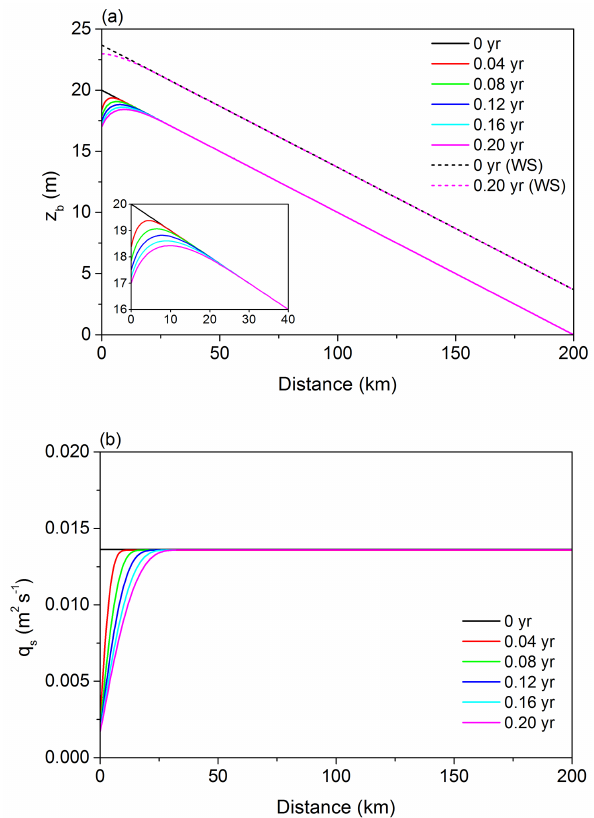
Figure 3. The 0.2-year results for the case of uniform sediment using the flux form of the Exner equation: time variation of (a) bed elevation z b and water surface (WS), (b) sediment load per unit width q s of the LYR in response to the cutoff of sediment supply. The inset shows detailed results near the upstream end.